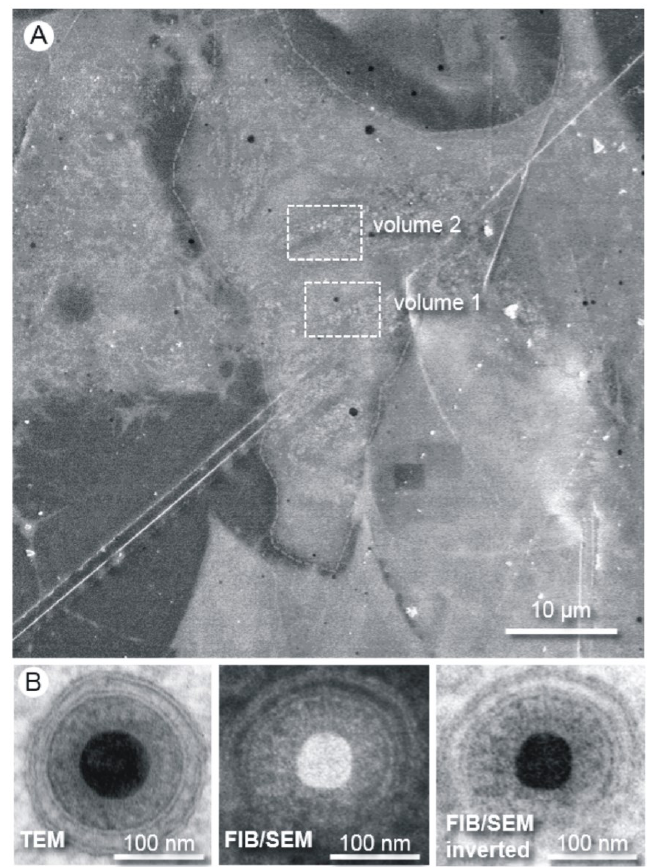
Figure 2. Methodology and resolution of FIB/SEM tomography. ( A ) The Epon embedded cells are first visualized by SEM at an acceleration voltage of 10 kV. A region of interest can be easily chosen for the subsequent “slice and view” process. The boxes show the positions of the volumes chosen for FIB/SEM tomography; ( B ) Images of human cytomegalovirus (HCMV) particles acquired from an ultrathin section by transmission electron microscopy (TEM) and from the block face by FIB/SEM. The high resolution of the FIB/SEM image allows clear visibility of the two leaflets of the lipid bilayer. The secondary electron SEM image was acquired with an acceleration voltage of 5 kV.